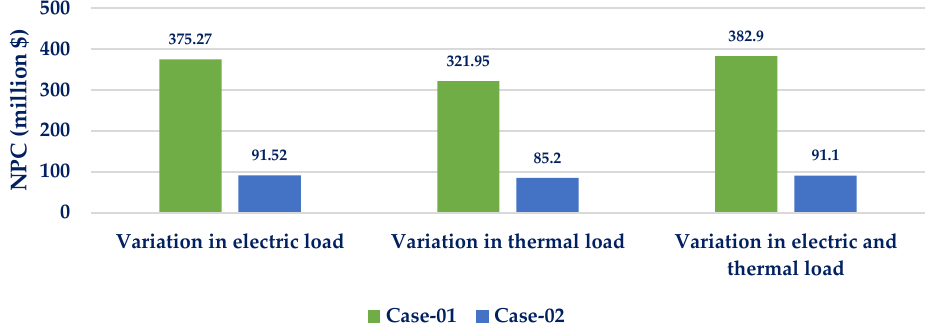
Figure 17. Impact on NPC due to daily peak demand variation.